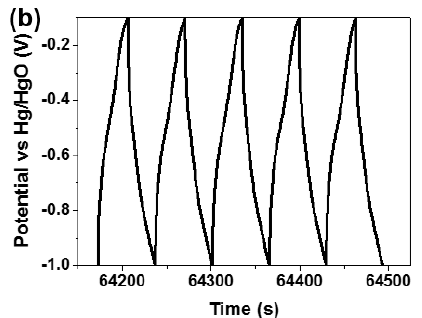
Figure 8. ( a ) Cyclic performances of MoS 2 /RGO hollow microsphere (black curve) and bare MoS 2